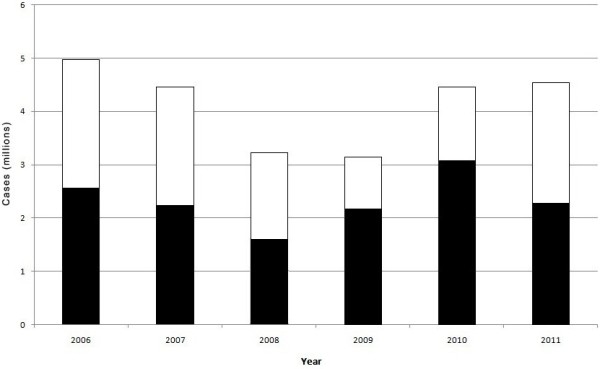
Malaria in Zambia by age groups, 2006 to 2011. (Black bars indicate cases < five years, open bars indicate cases ≥ five years).